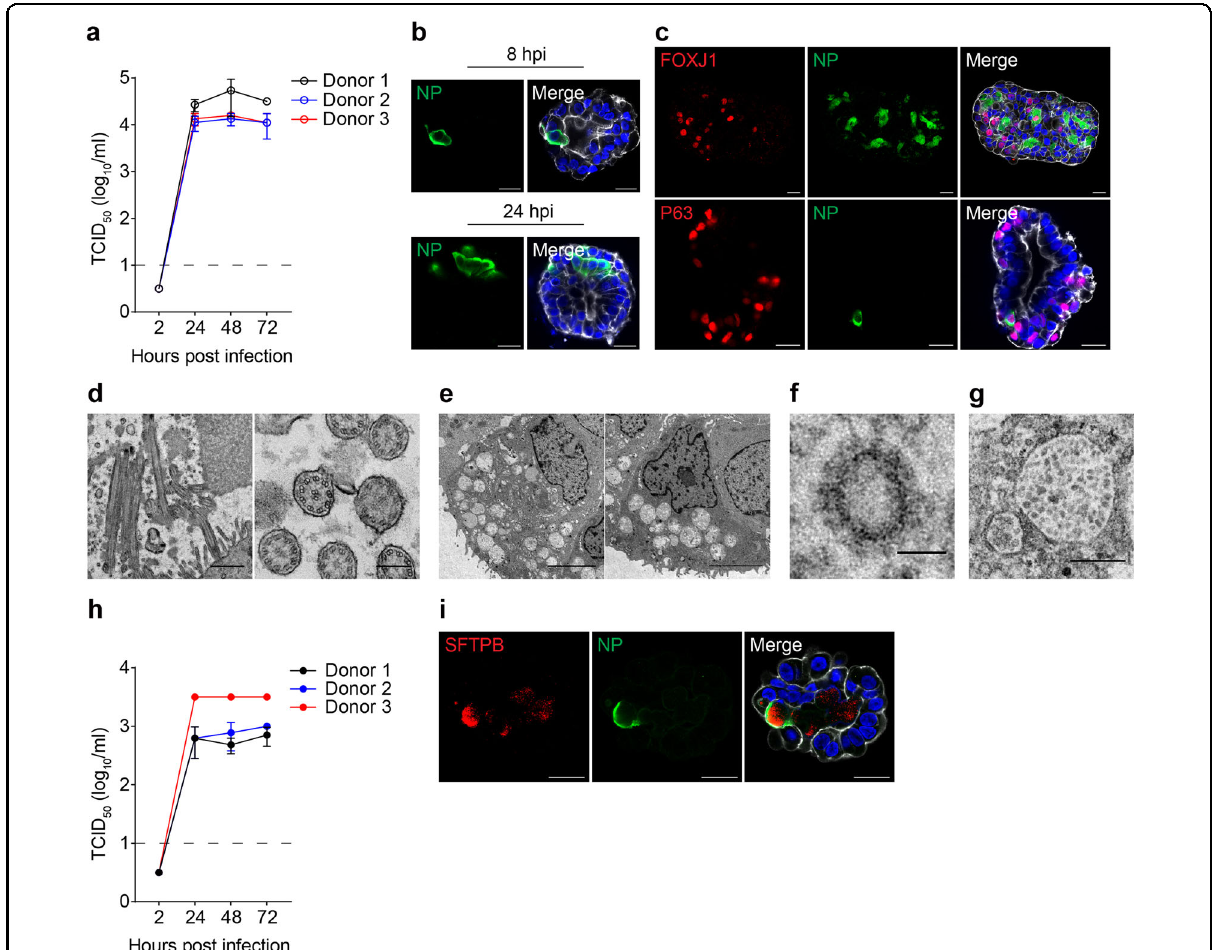
Fig. 4 SARS-CoV-2 replication in 3D airway organoids and alveolar organoids. a At the indicated hours post-infection, culture media were harvested from three lines of 3D AwOs infected with WT SARS-CoV-2 (MOI = 1) and applied to viral titration by TCID 50 assay. Data represent means ± SD in three organoid lines, n = 3 for each line. The dashed line indicates the detection limit. b 3D AwOs inoculated with SARS-CoV-2 (MOI = 2) were fi xed at 8 or 24 hpi and immunostained to identify viral nucleoprotein (NP, green) positive cells. Nuclei and actin fi laments were counterstained with DAPI (blue) and Phalloidin-647 (white), respectively. Scale bar, 20 µm. c After fi xation at 24 hpi, SARS-CoV-2-infected AwOs were co-stained with α -NP (green) and α -FOXJ1 (red, top) or α -P63 (red, bottom). Scale bar, 20 µm. d – g Representative microphotographs of transmission electron microscopy. d Ciliated cells. Longitudinal section (left, scale bar 1 µm) and cross-section (right, scale bar 200 nm) of cilia showing microtubules with a 9 + 2 arrangement. e Goblet cells. Scale bar, 4 µm. f A virion particle in the cytoplasm of SARS-CoV-2-infected (MOI = 5) airway organoids. Scale bar, 50 nm. g Virion particles in a secretory vesicle in a cell of infected organoids. Scale bar, 400 nm. h At the indicated hours post-infection, culture media were harvested from three lines of AlvOs infected with WT SARS-CoV-2 (MOI = 1) and applied to viral titration by TCID 50 assay. Data represent means ± SD in three organoid lines, n = 3 for each line. i Representative confocal images of SARS-CoV-2-infected SFTPB + AT2 cells in an AlvO (MOI = 2). Scale bar, 20